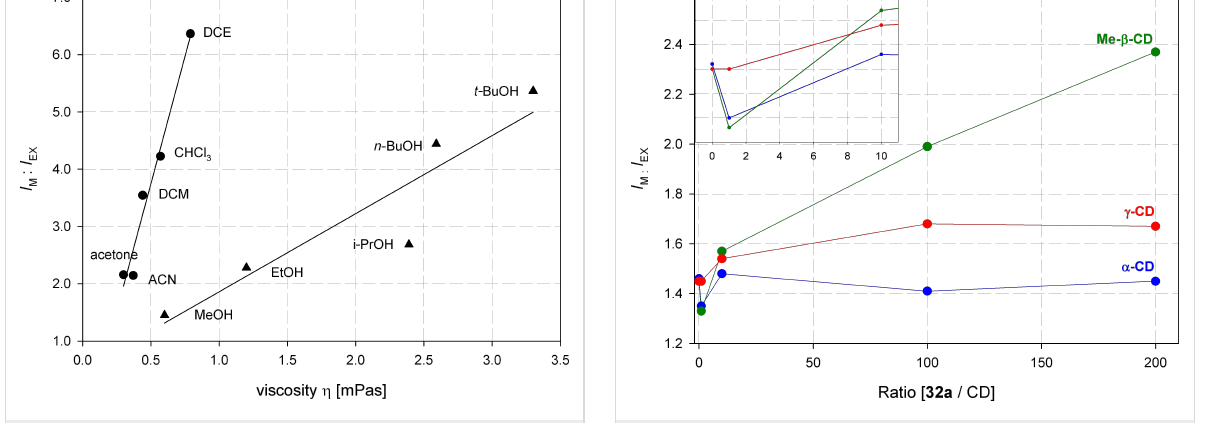
Figure 5: Monomer–excimer ratio I M / I EX of the fluorescence of 32a depending on solvent viscosity (DCE = 1,2-dichloroethane, DCM = dichloromethane, ACN = acetonitrile).